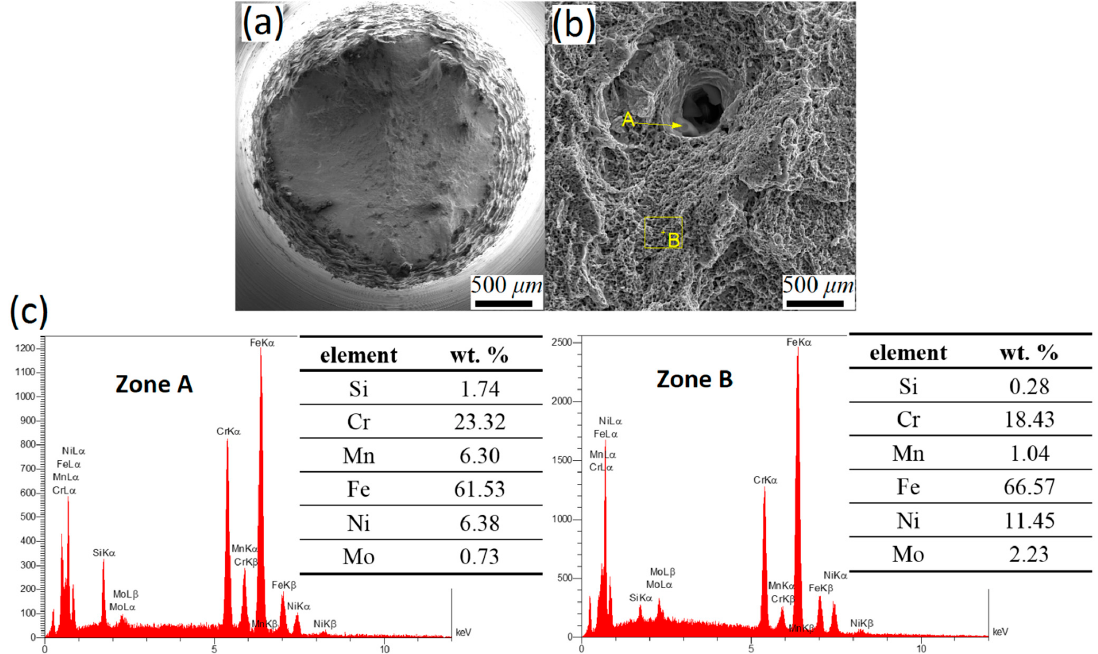
Figure 6. SEM images of the fractured surfaces of C-4.8 sample: ( a ) low magnification, ( b ) high magnification, and ( c ) EDS analysis of the points A and B, respectively, in ( b ). EDS peaks are X-rays given off as electrons return to the K electron shell (K-alpha (K α ) and K-beta (K β ) lines).